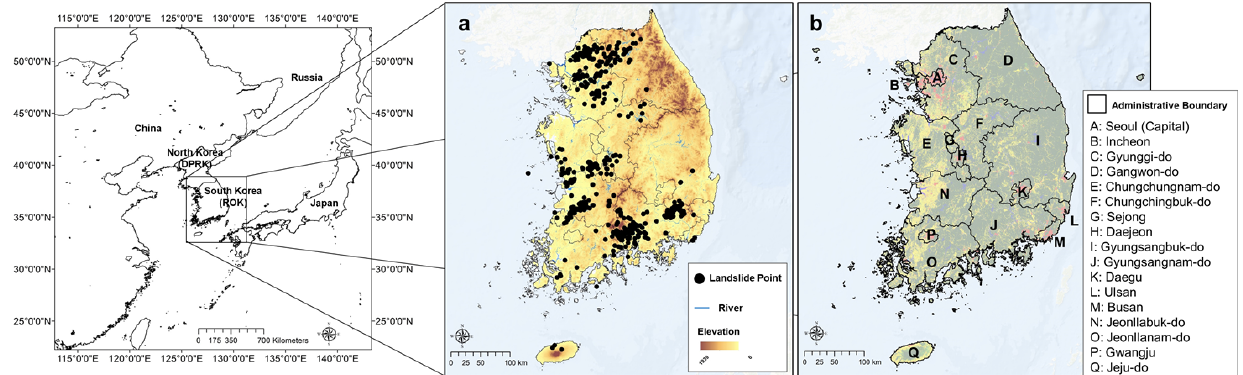
Figure 1. ( a ) Study area indicating the region where landslide occurred in 2011 and ( b ) administrative